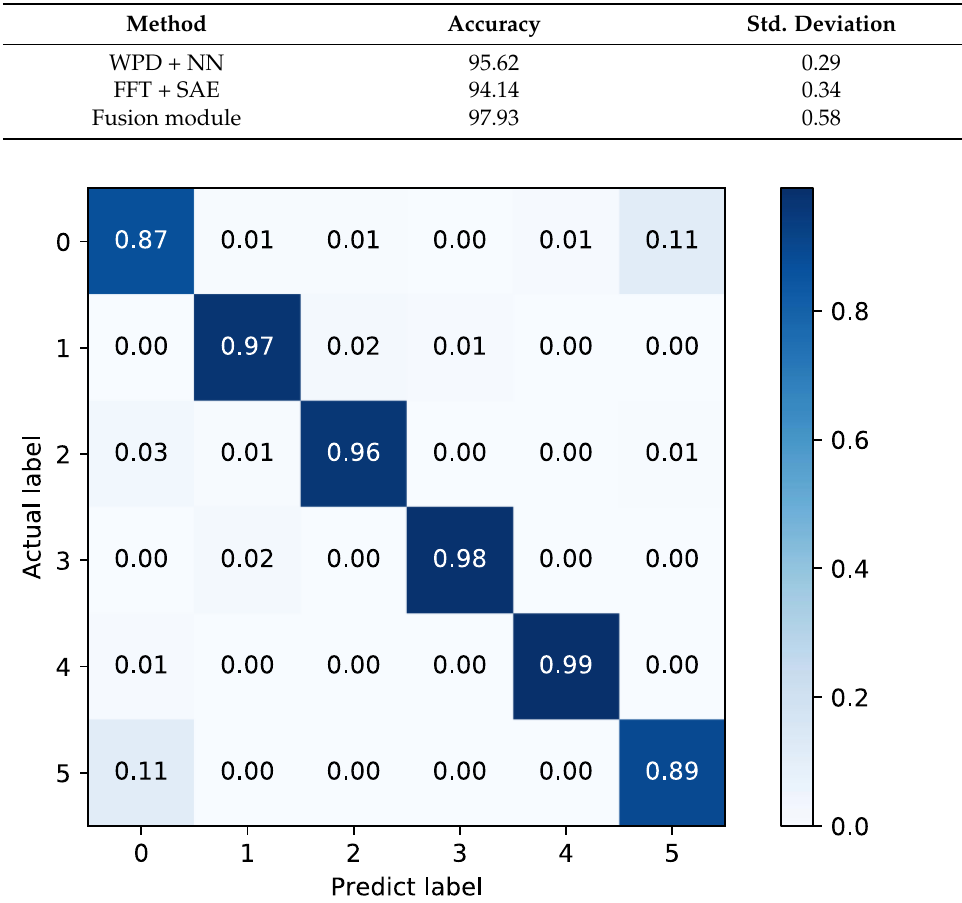
Figure 16. Confusion matrix of FFT + SAE.